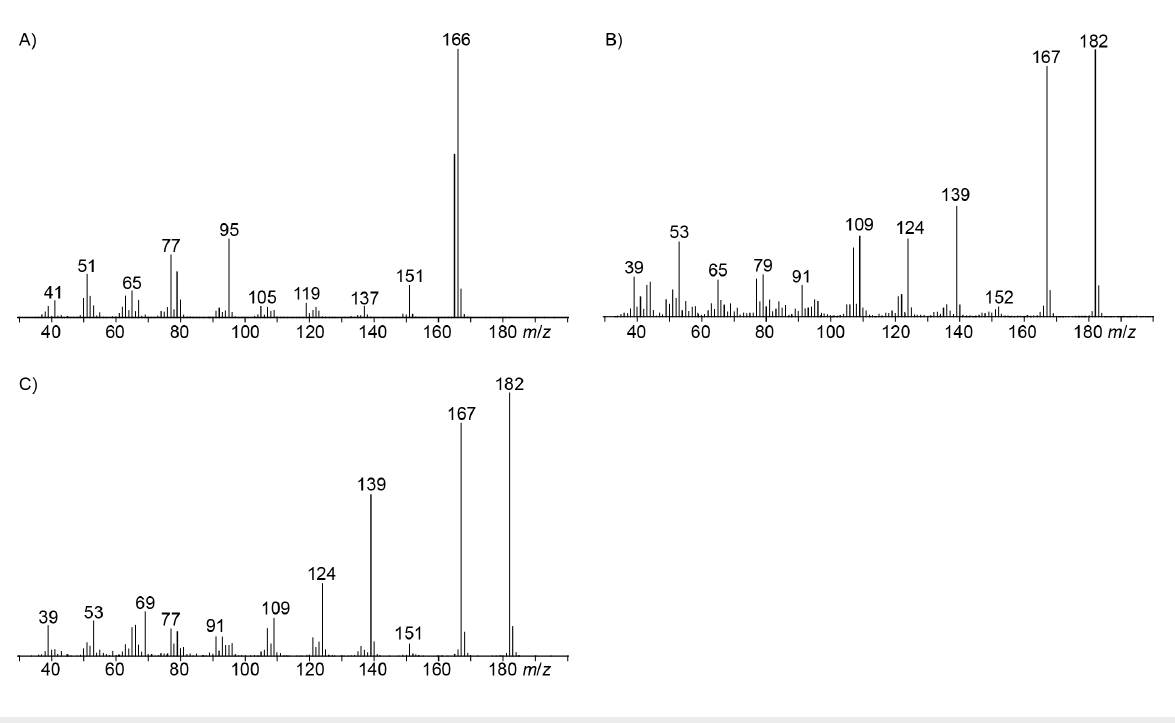
exhibited a mass spectrum that pointed to the structure of a dimethoxybenzaldehyde (Figure 8A). Comparison to all six commercially available isomers (Table 6) showed the identity of the natural product and 3,4-dimethoxybenzaldehyde ( 42 ). Finally, two trace compounds with almost identical mass spec- tra (Figure 8B and Figure 8C), but clear separation by gas chro- matography, were suggested to be trimethoxytoluenes.